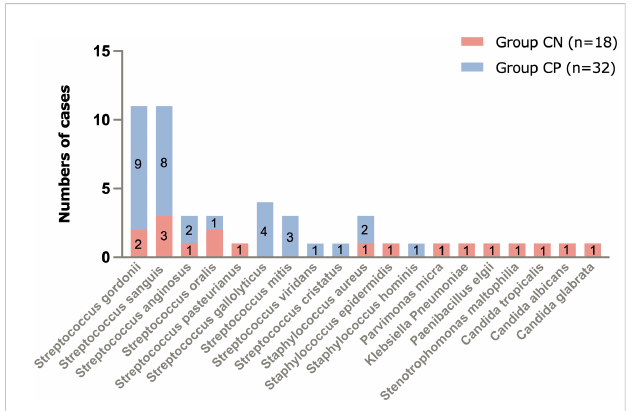
FIGURE 2 Pathogens of IE detected by blood mNGS and number of cases. mNGS, metagenomic next-generation sequencing; IE, infective